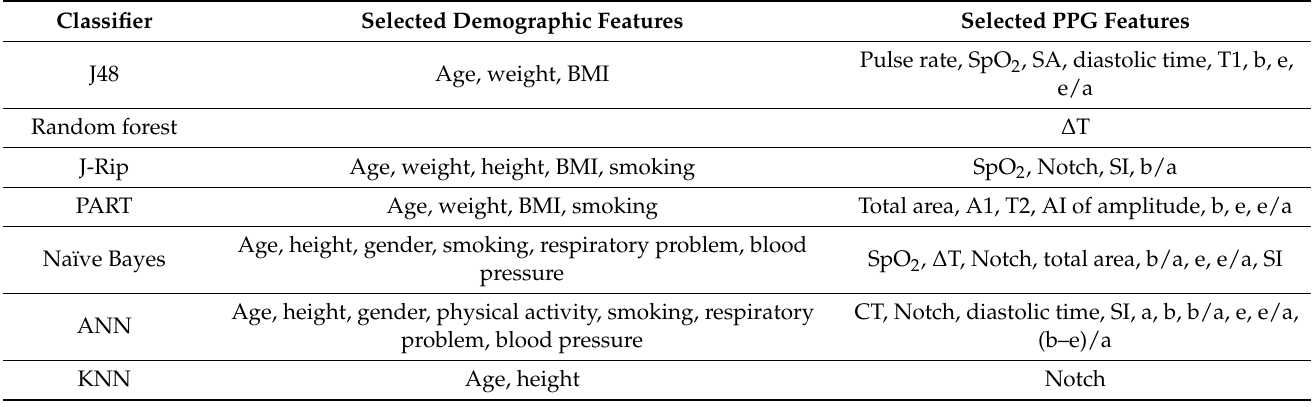
Table 4. Selected features by each classifier in the second stage.